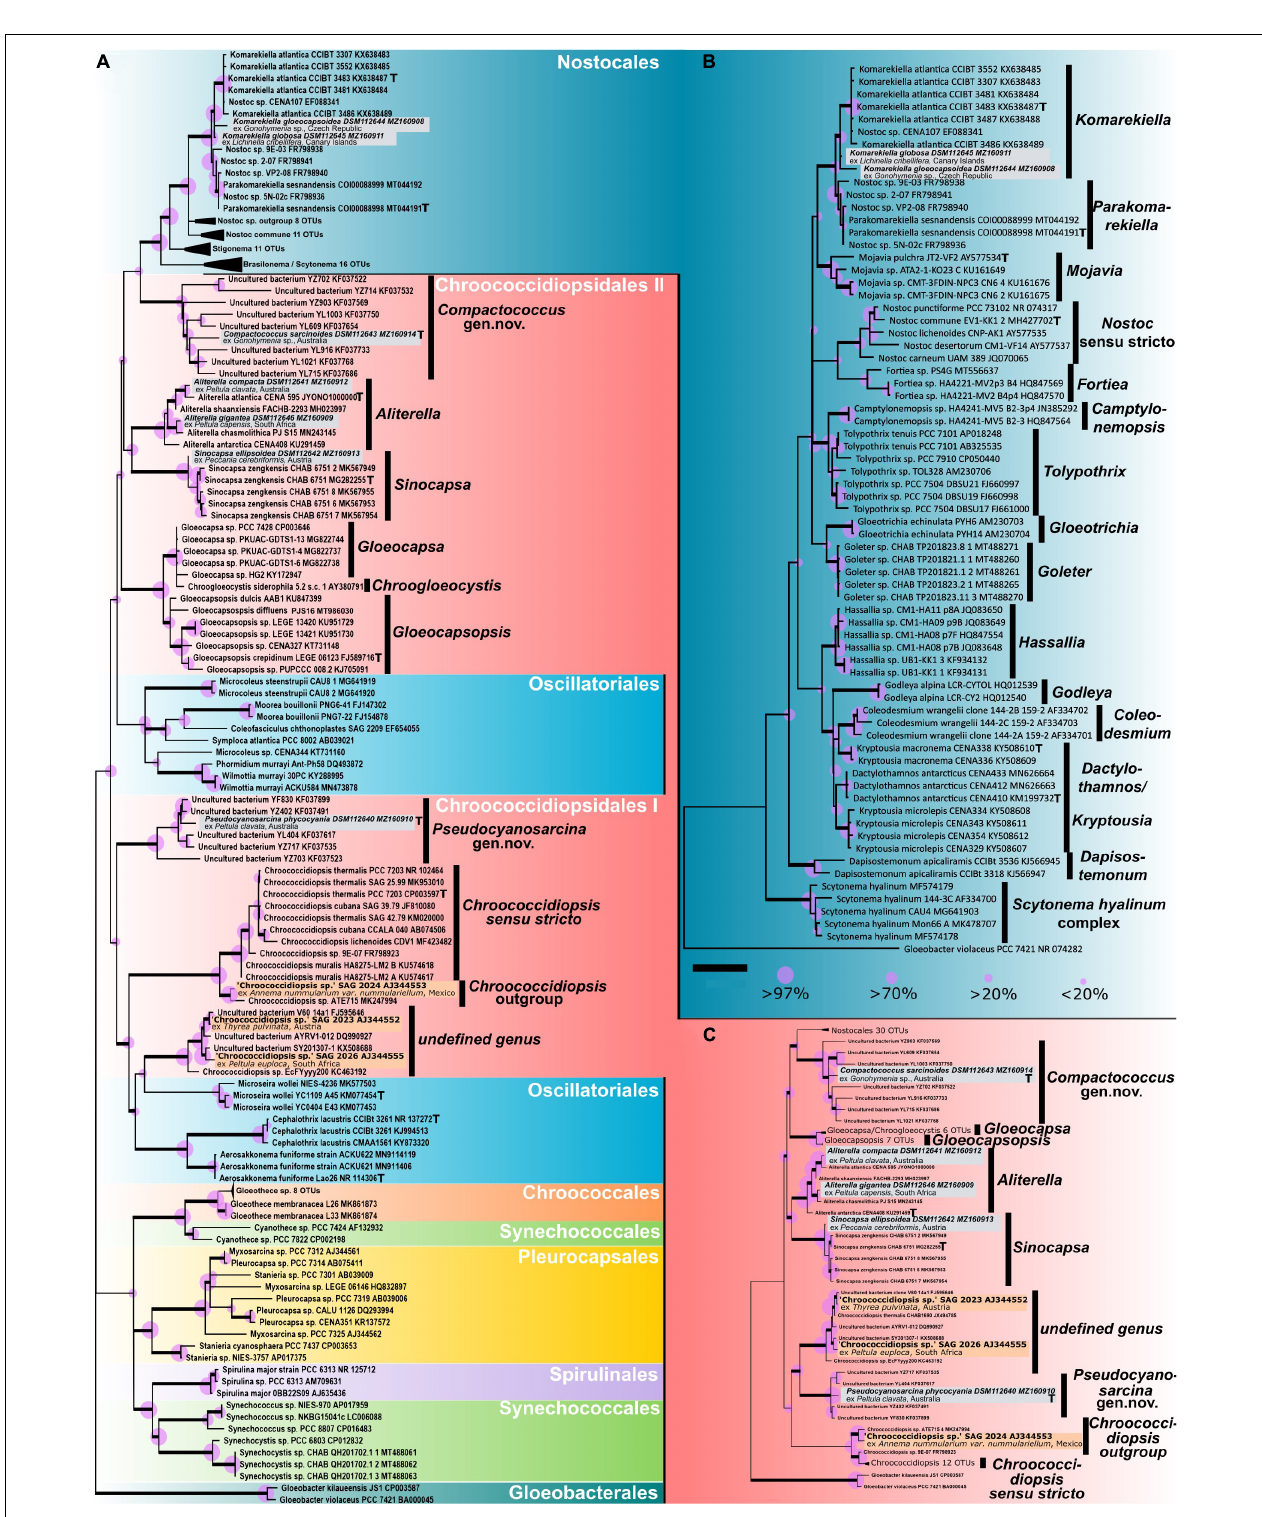
FIGURE 1 | Phylogenetic maximum likelihood (ML) trees based on the 16S rRNA gene region of the isolated photobionts. (A) ML phylogenetic tree comprising 105 sequences (1,438 bp) of representatives from all cyanobacterial orders rooted to Gloeobacter , giving an overview of the almost complete taxonomy of the phylum. (B) ML phylogenetic tree comprising 71 sequences (1,505 bp) of main nostocalean representatives rooted to Gloeobacter , giving a detailed overview of the nostocalean taxonomy. (C) ML phylogenetic tree comprising 92 sequences (1,438 bp) of all chroococcidiopsidalean representatives with Nostocales as